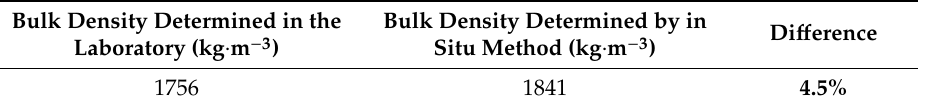
Table 8. Comparison of the bulk density of the raw material in the area of interest of the deposit, determined by the laboratory and the in situ